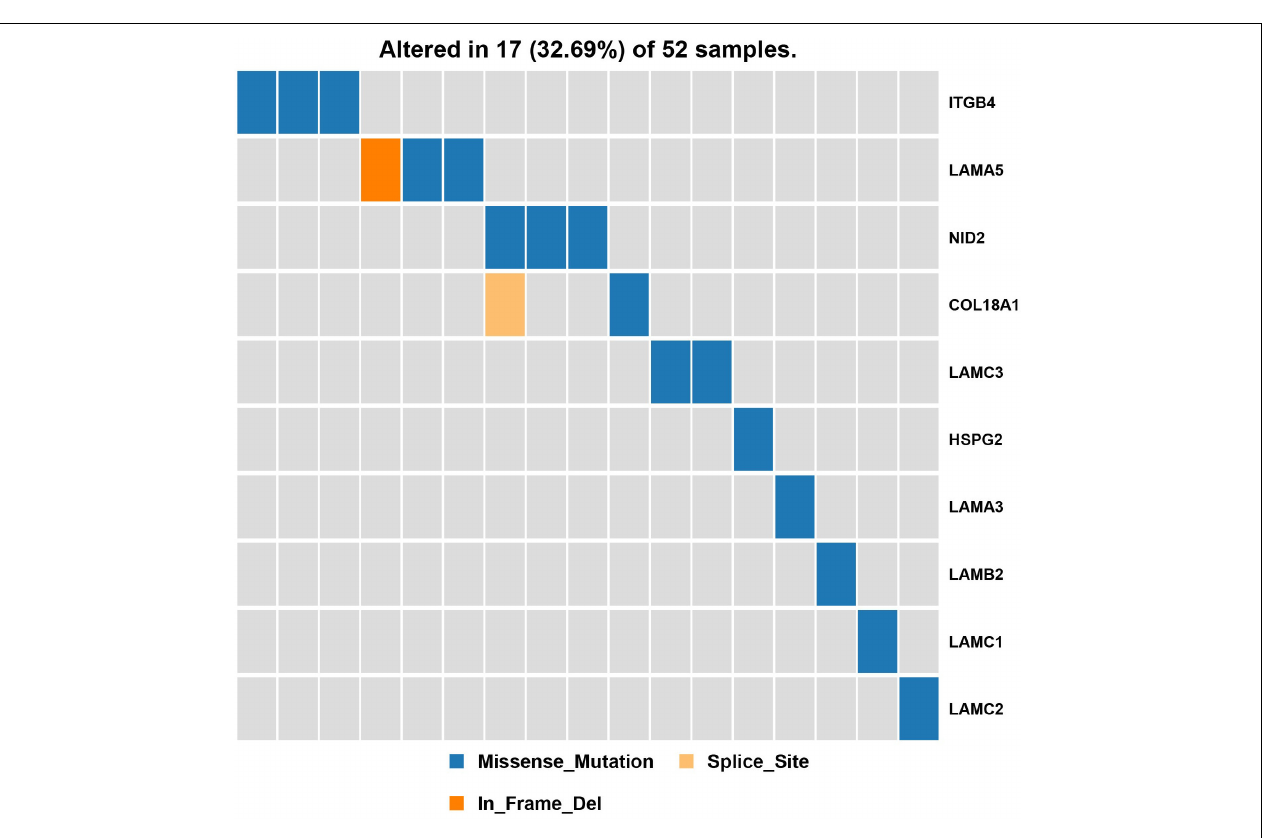
FIGURE 5 | Results of the pathway enrichment analysis of genes found to be mutated in the analyzed hemifacial microsomia (HFM) patient cohort. The “laminin-interaction” pathway was predicted to be most significantly affected by the identified mutations (most often in ITGB4 , LAMA5, or NID2 ) and was likely disrupted in 17 (32.69%) of the analyzed